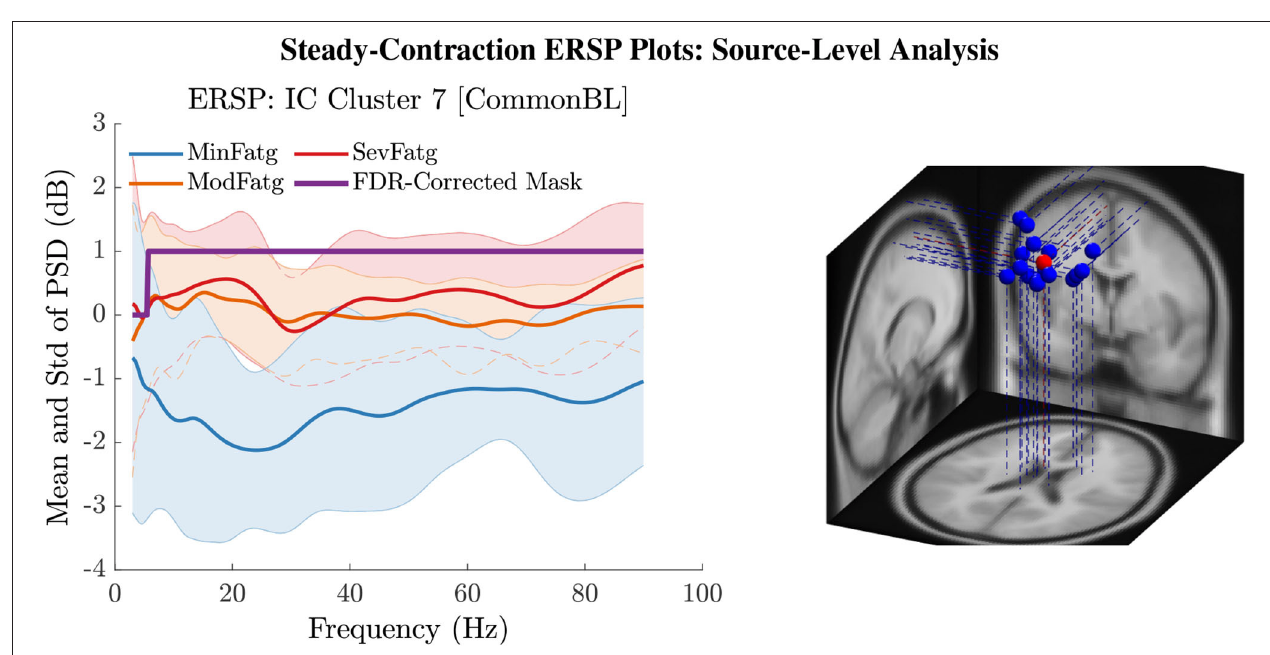
FatgCond FIGURE 7 | The steady-contraction ERSP averaged over time, ∼ ERSP , portrays how the PSD for IC Cluster 7 modulates across MinFatg, ModFatg, and SevFatg, as a function of frequency (left panel). The FDR-corrected mask indicates that a statistically significant ( p < 0.05) difference in PSD between the three fatigue conditions is maintained throughout the EEG frequency spectrum except the delta band. The brain sources (ICs) marked as equivalent dipoles (blue dots) in Cluster 7 and the cluster centroid (red dot) are located in vicinity to the right paracentral lobule (right panel).